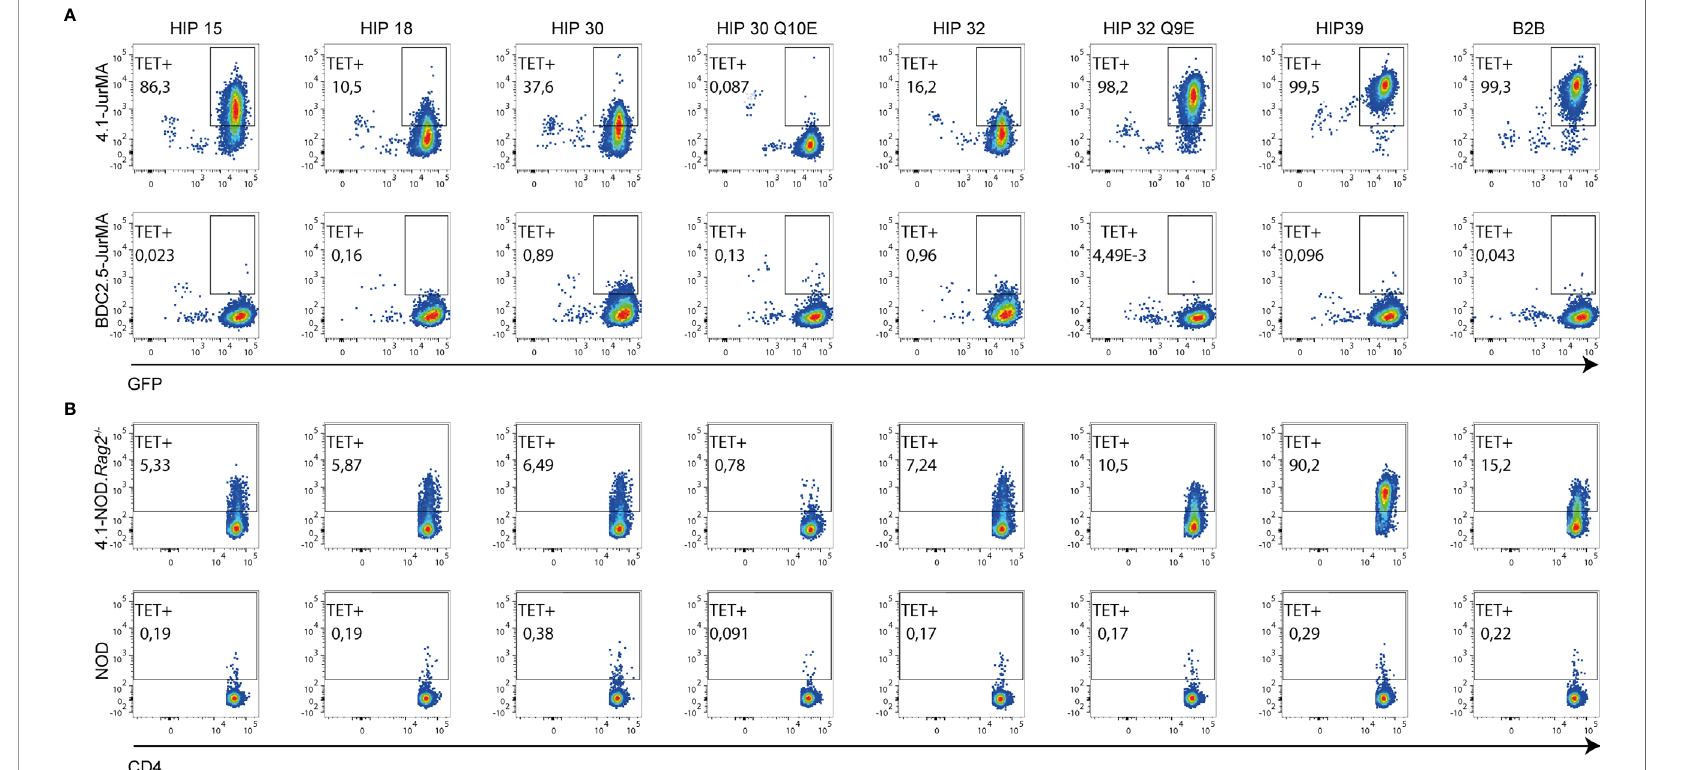
FIGURE 5 | Multiple binding af fi nities of 4.1-TCR to different HIP-based I-A g7 tetramers. Representative FACS plots illustrating the ability of 7 pMHCII tetramers displaying different HIPs to bind 4.1- vs. BDC2.5- JurMA cells (A) or splenic CD4+ T cells from 4.1-NOD. Rag2 − / − vs. NOD mice (B) . The B2B-I-A g7 tetramer was employed as positive control of staining. GFP is a readout for TCR expression in the JurMA